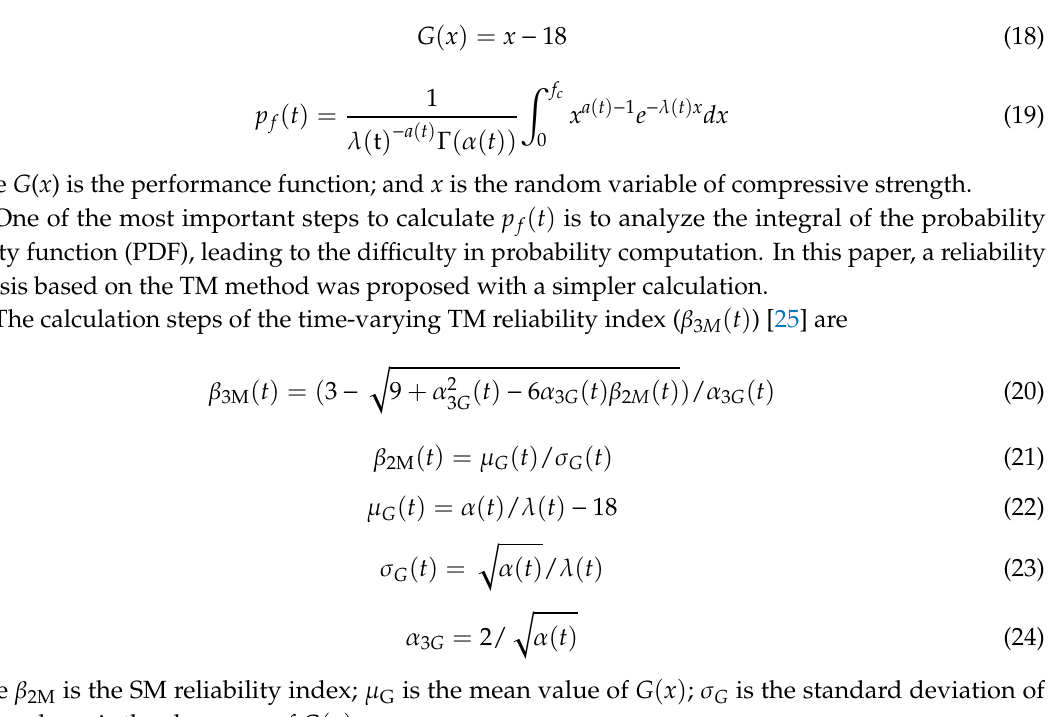
Figure 14. Scale parameter ( 2